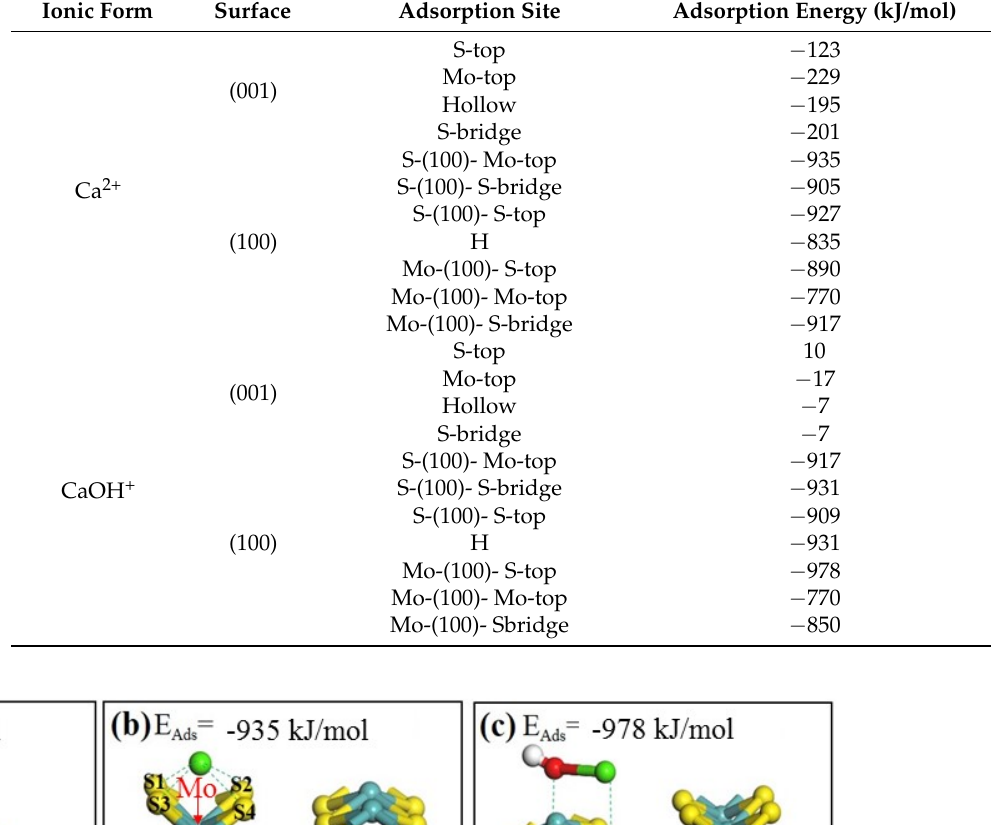
Table 3. Adsorption energies of calcium ions on molybdenite surfaces.